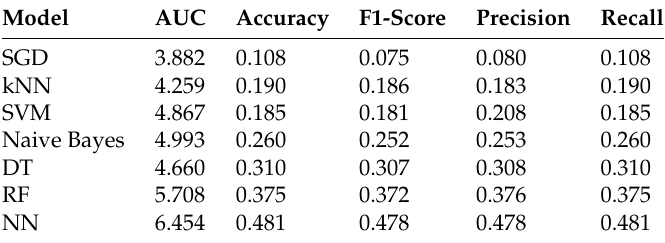
Table 9. Classification results using raw accelerometer, gyroscope, and magnetometer measurements. Model